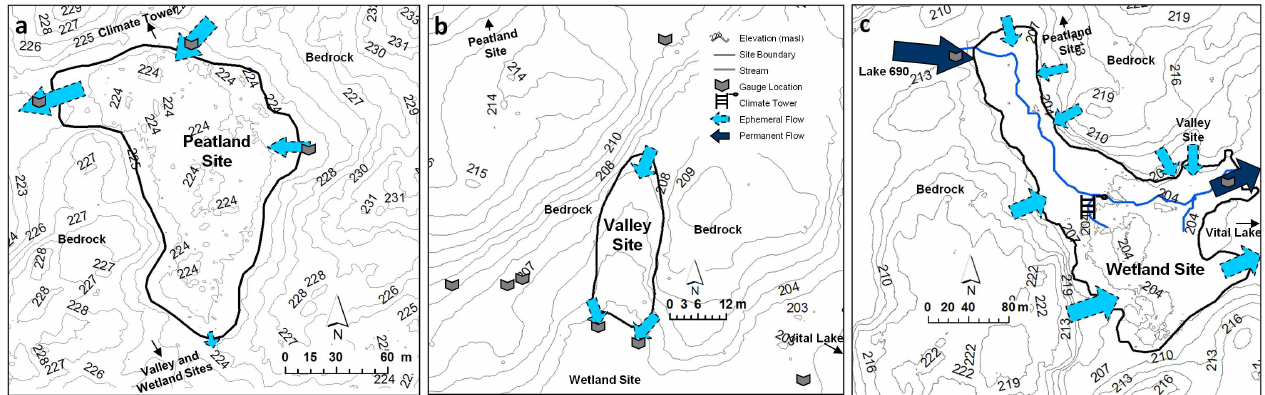
Fig. 1. Main surface flow lines and elevation map of the study sites. The contour interval at the peatland site (a) is 1m, 1m at the valley site (b) and 3m at the wetland site (c) . Elevations are referenced to meters above sea level. Size of arrows is proportional to flow magnitude (e.g. larger arrow indicates relatively greater water flow). Table 1. Site area, topographic gradient based on 1m by 1m digital elevation model, shallow soil characteristics (top 0.10m) and saturated hydraulic conductivity ( K ) at each site. Shallow and deep K are at pipe slot depths described in Sect. 3.1.4. Site Peatland Valley Wetland Area (ha) 1.4 0.04 3.3 Gradient (%) 3 12 6 Soil Porosity 0.85 0.83 0.80 Soil Bulk Density (kgm − 3 ) 78 Soil Particle Density (kgm − 3 ) Specific